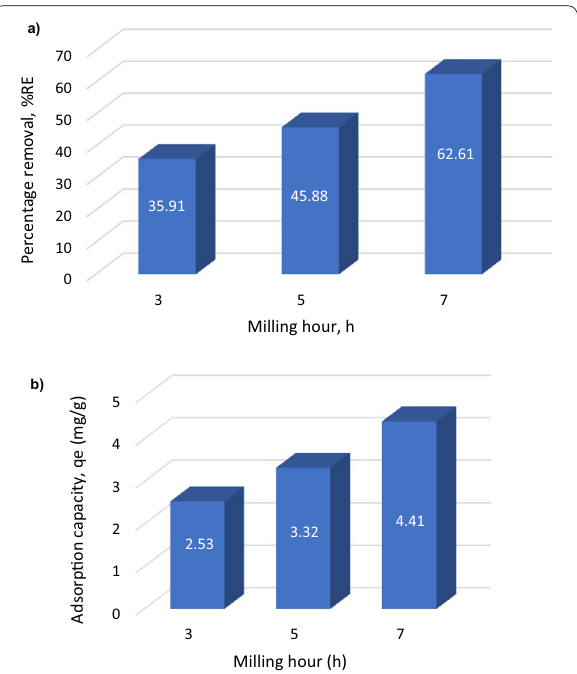
), s Fig. 5 a The bar chart of percentage removal; b metal uptake/ adsorption capacity of MNP onto Cu 2 + at different milling